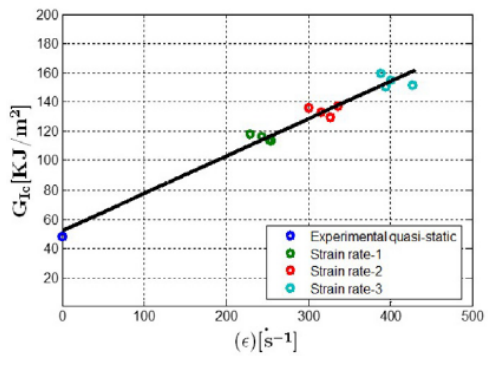
Figure 2. Mode-I fracture toughness versus strain rate of a carbon fiber reinforced composite